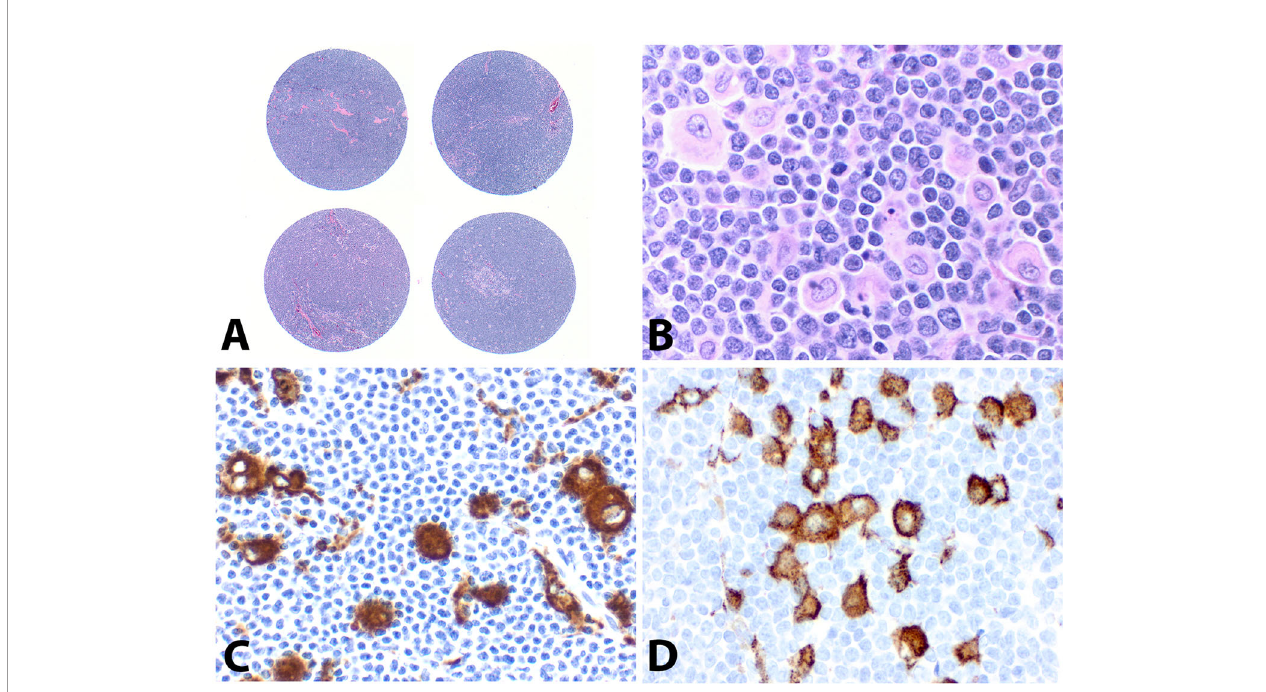
FIGURE 1 | Construction of tissue microarray (TMA) and immunostains of CD68 and CD163. (A) Each MCL case had two separate 1.0 mm cores on the TMA (H&E, original magni fi cation ×20). (B) Scattered epithelioid histiocytes admixed with abundant lymphoma cells (H&E, ×400), which were highlighted by immunostains with CD68 ( C , ×400) and CD163 ( D ,